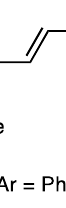
Table 1. Screening of the reaction conditions for the palladium-catalyzed dehydrogenative alkenyl- ation of 1-methyl-5 (4-methoxyphenyl)imidazole ( 1a ) with styrene ( 2a